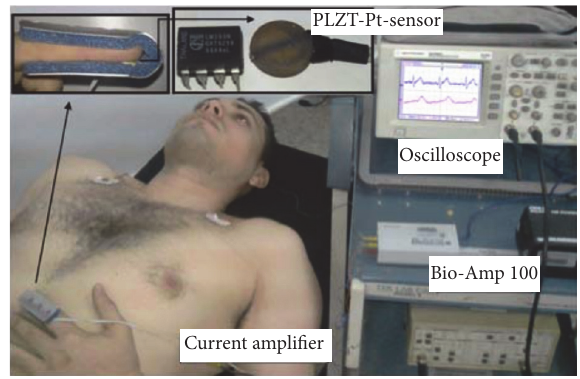
Figure 4: First experimental setup of the obtained micropulsations from PLZT-Pt sensor.